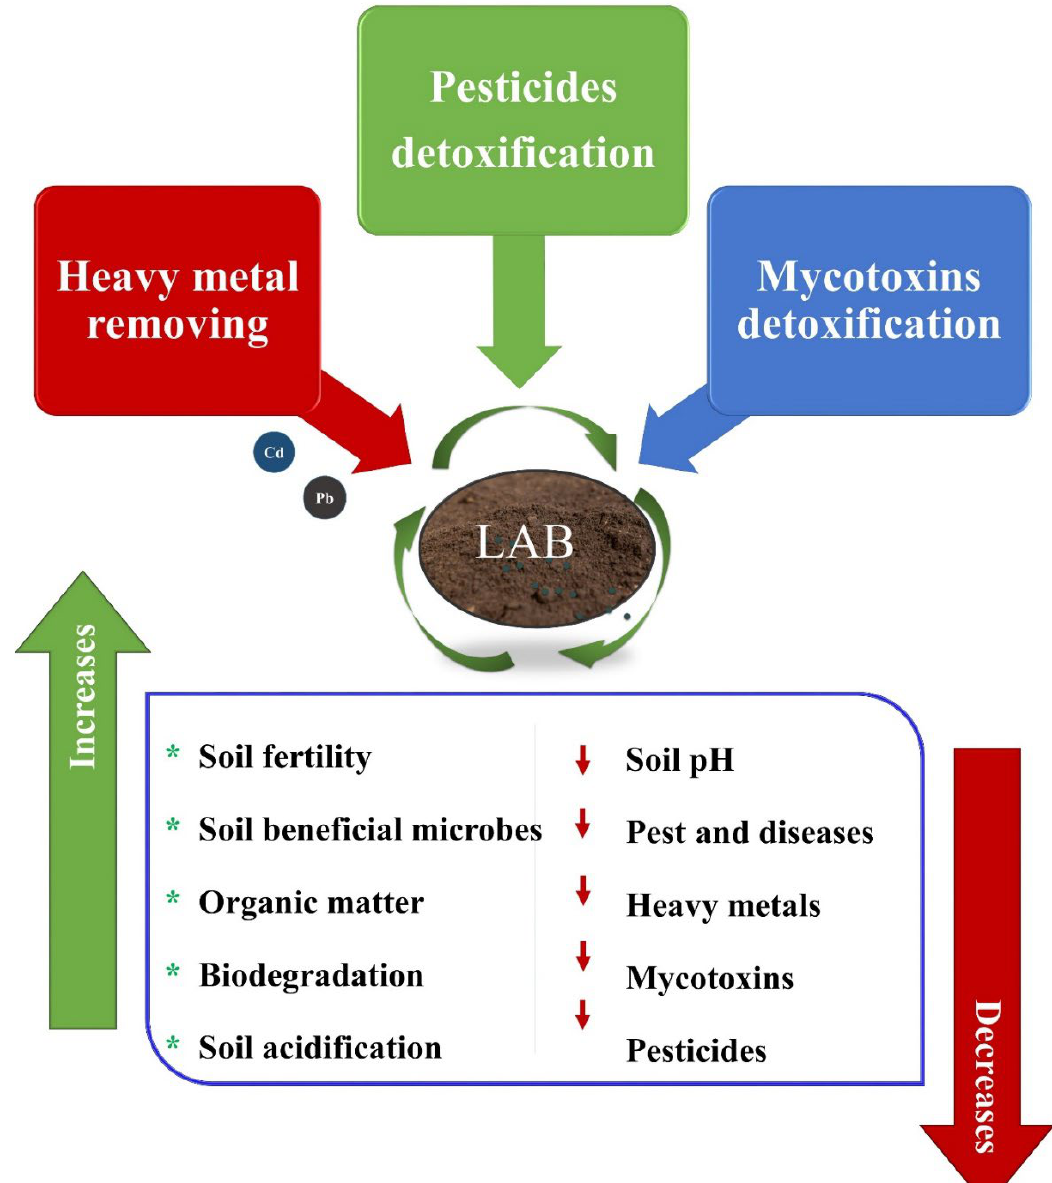
Figure 3. The role of LAB in bioremediation for sustainable agriculture.